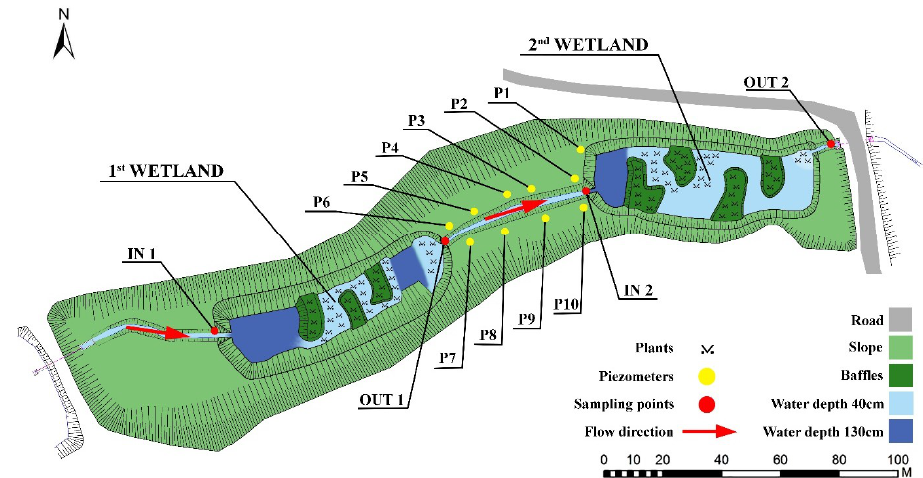
Figure 1. Layout of the Vända free water surface constructed wetland system (0.45 ha) capturing runoff from 2.2 km 2 catchment area.